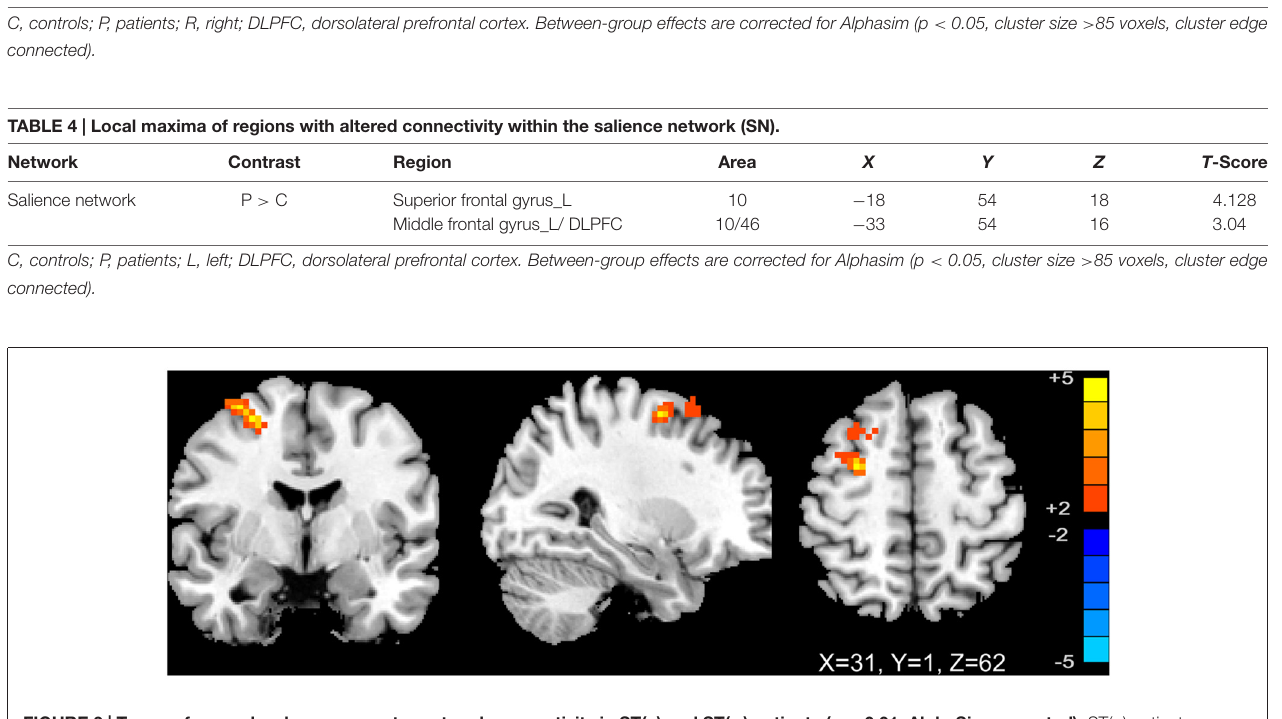
through AlphaSim correction. Regarding the SMN, increased connectivity was found after treatment in the left SMA and right premotor cortex, and decreased connectivity was found in the right SMA and right precentral gyrus. The right inferior parietal cortex (BA 48), middle frontal gyrus (BA 46), superior frontal gurus (BA 8) and middle temporal gurus (BA 20) demonstrated increased connectivity within rFPN after BoNT